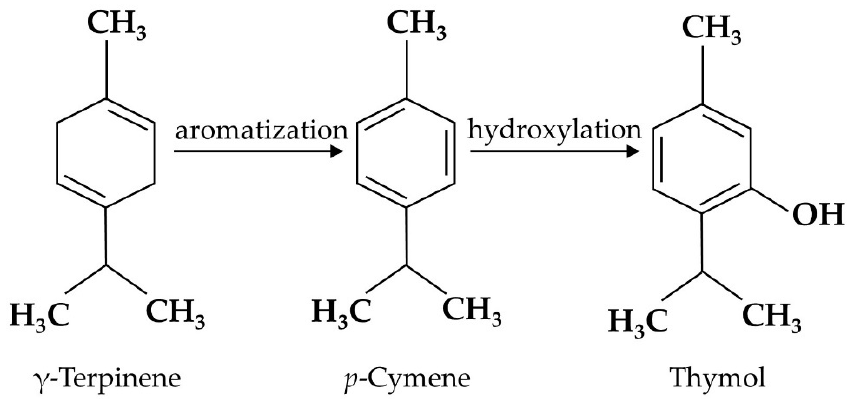
Figure 1. Thymol biosynthesis in plants. Thymol is synthesized by the hydroxylation of p -cymene, which originates from the aromatization of γ -terpinene.